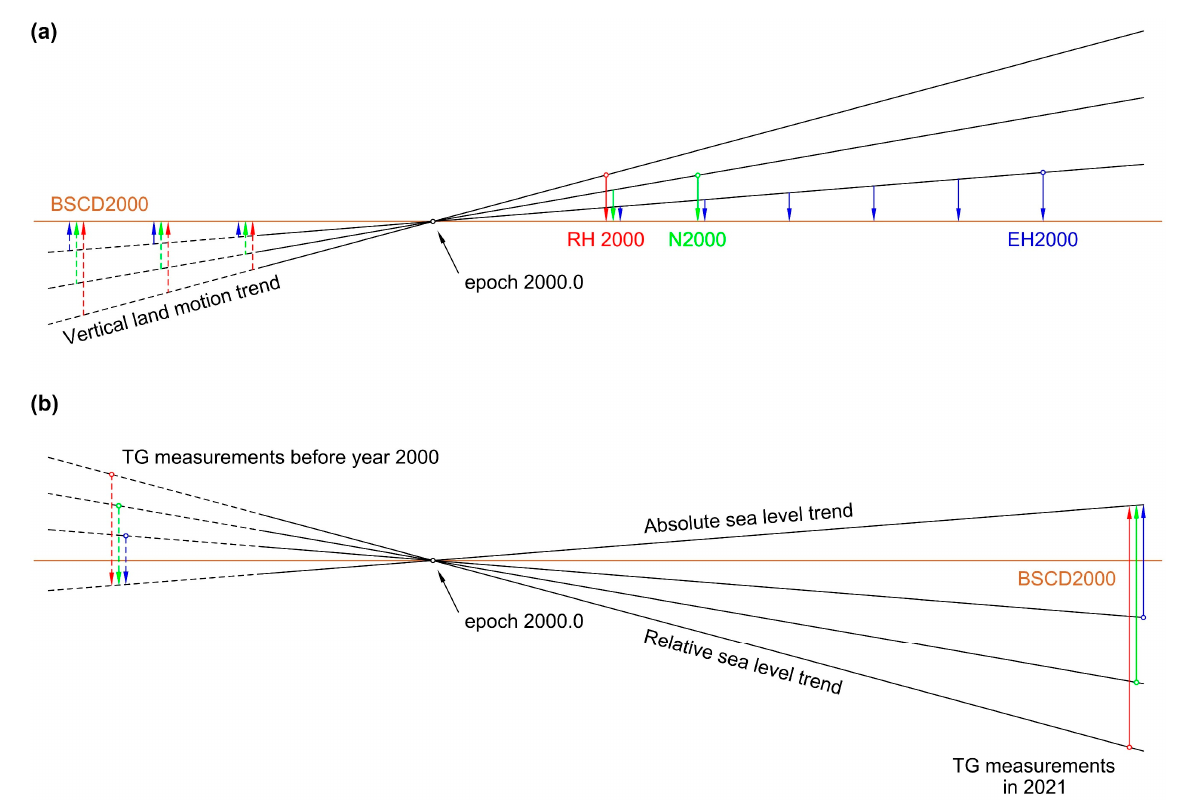
Figure 3. Simplified schematics of ( a ) reductions of leveling observations to a common uplift reference epoch 2000.0 (the three tilted lines symbolize different VLM rates at different locations) and ( b ) application of VLM correction to the TG time series (for simplicity, the DT is assumed zero at the time-epoch 2000.0). Note that the separation between BSCD2000 and absolute sea level trend in ( b ) represents rising sea levels. The dashed lines and arrows denote historical data since the beginning of measurements.